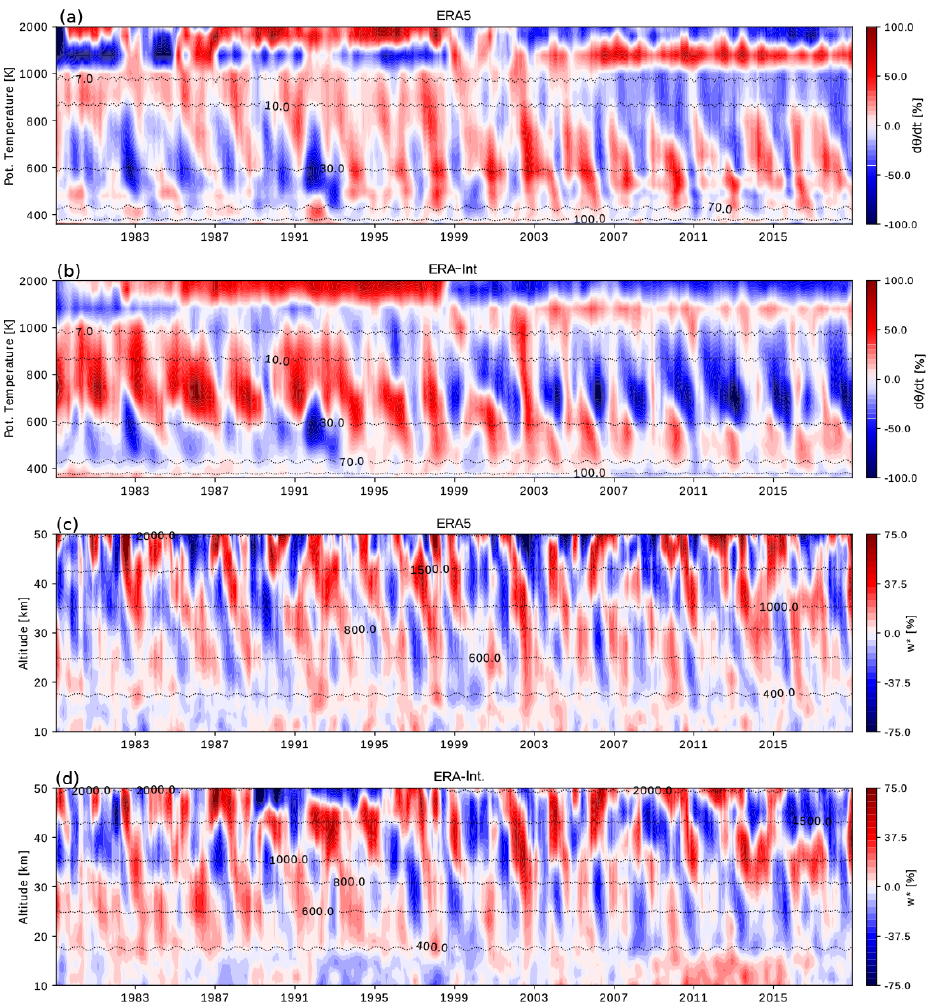
Figure 12. Tropical average monthly mean anomaly time series of total diabatic vertical velocities from ERA5 (a) and ERA-Interim (b) , and residual circulation vertical velocity w ∗ from ERA5 (c) and ERA-Interim (d) . Data have been averaged over 30 ◦ N–30 ◦ S, deseasonalized by subtracting the mean annual cycle, and percentage values have been calculated with respect to the climatological mean. The thin black dashed lines show pressure (a, b) and potential temperature (c, d) levels. Note the scaled potential temperature y axis above 1000K (in panels a and b ), in order to emphasize the lower